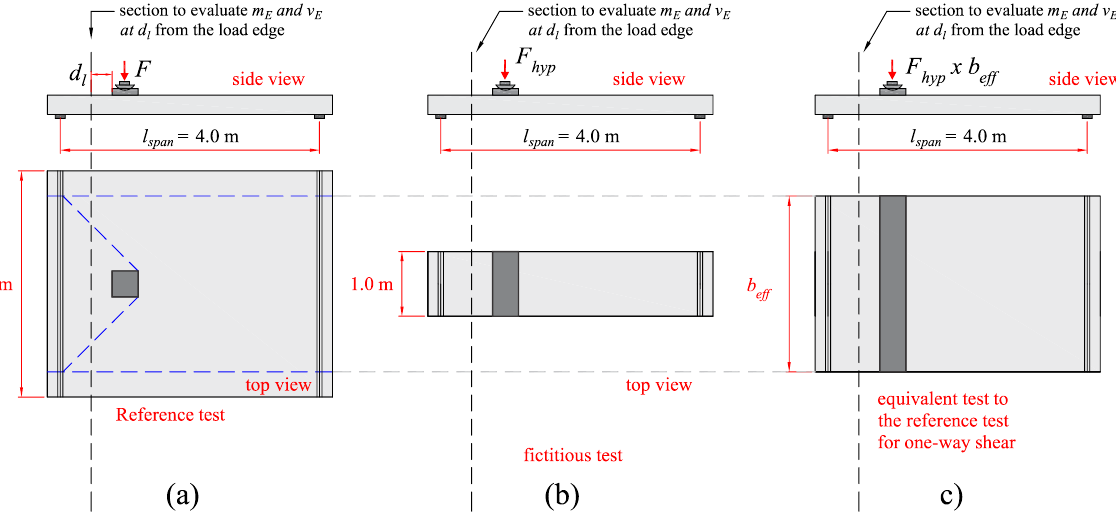
Figure 5. Proposed approach to calculate the relation between the applied concentrated load and the acting shear v E and bending moments m E when using the fib Model Code 2010 expressions for one-way shear: ( a ) Sketch of a test to be evaluated; ( b ) assumption of fictitious a test with 1 m width with equal support conditions to calculate v E , m E and, subsequently, the unitary shear capacity v R ; ( c ) multiplying of the test sketched in ( b ) by the respective effective shear width calculated in ( a ).